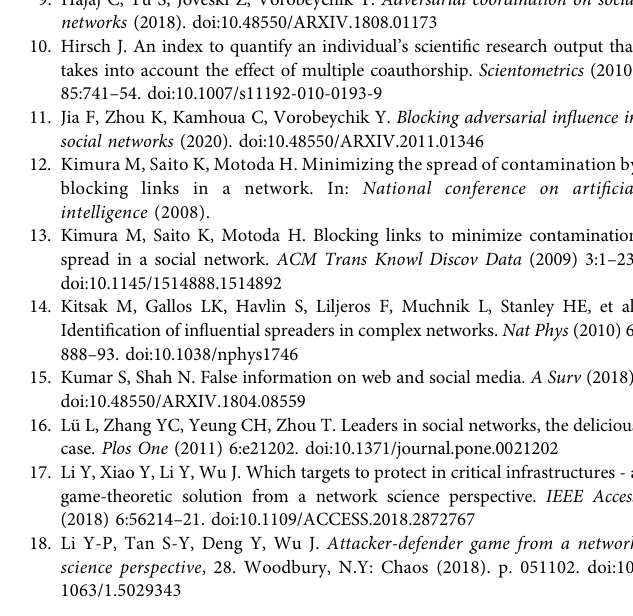
Figure 9 . We can fi nd that as the number of spreader ’ s seed nodes grows, the increment of blocker ’ s seed nodes is much larger than the increment of spreader ’ s if we want to achieve the same equilibrium utility